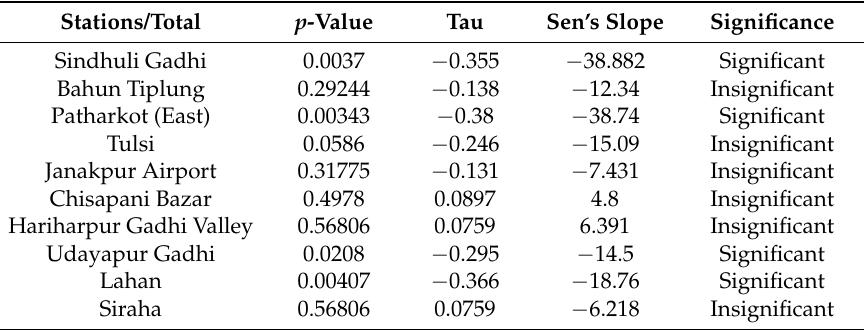
Table 5. Total annual rainfall trend for 10 stations.